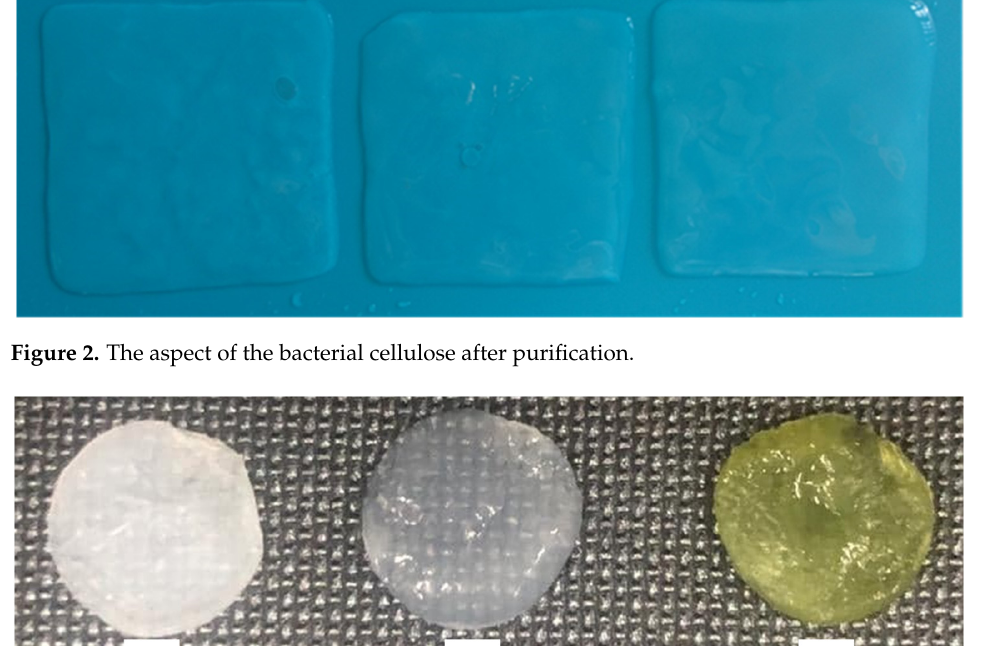
Figure 2. The aspect of the bacterial cellulose after purification.